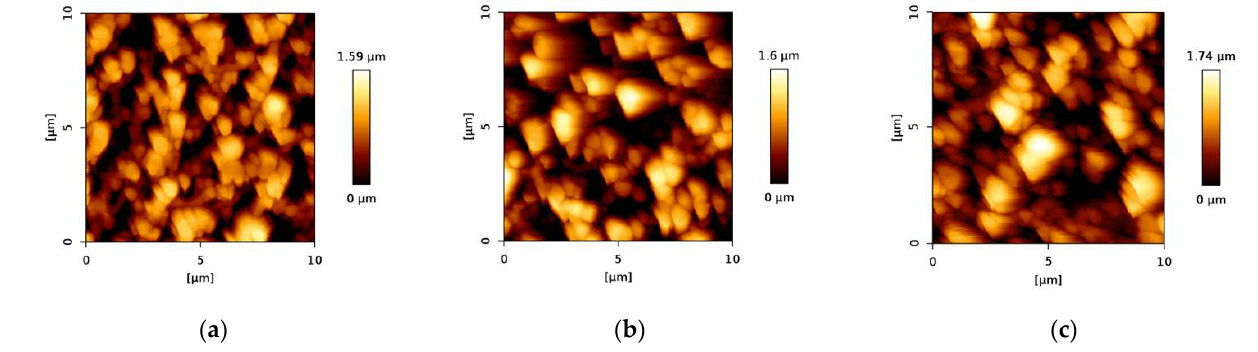
Table 2. RMS values after major functionalization steps.